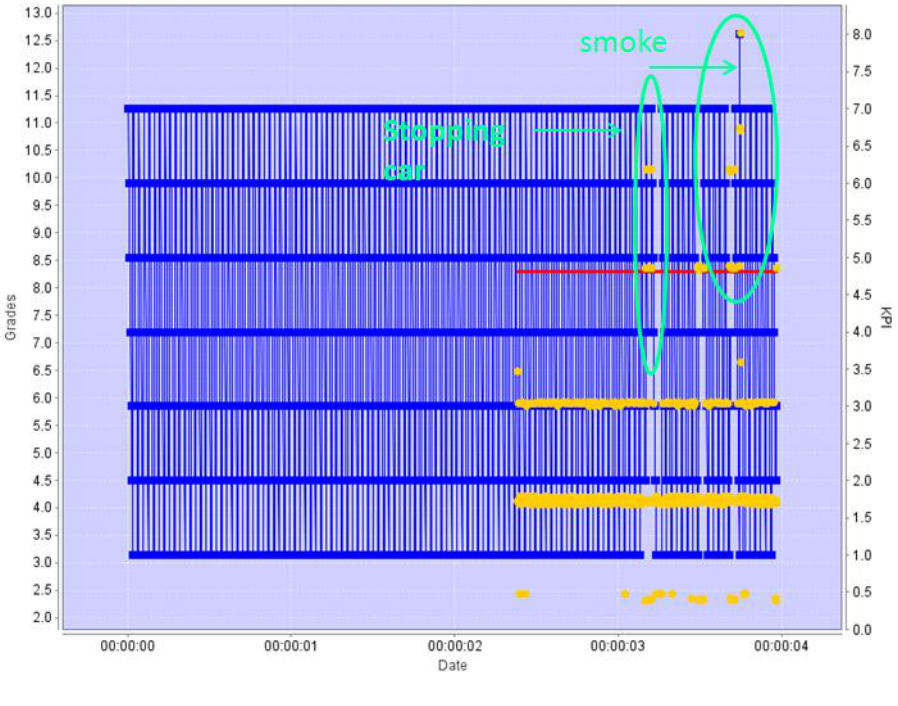
Figure 11. Stopping car—the normal movement KPI were recognized as a stable pattern. Once a change in the velocity data pattern was recognized—an alert is